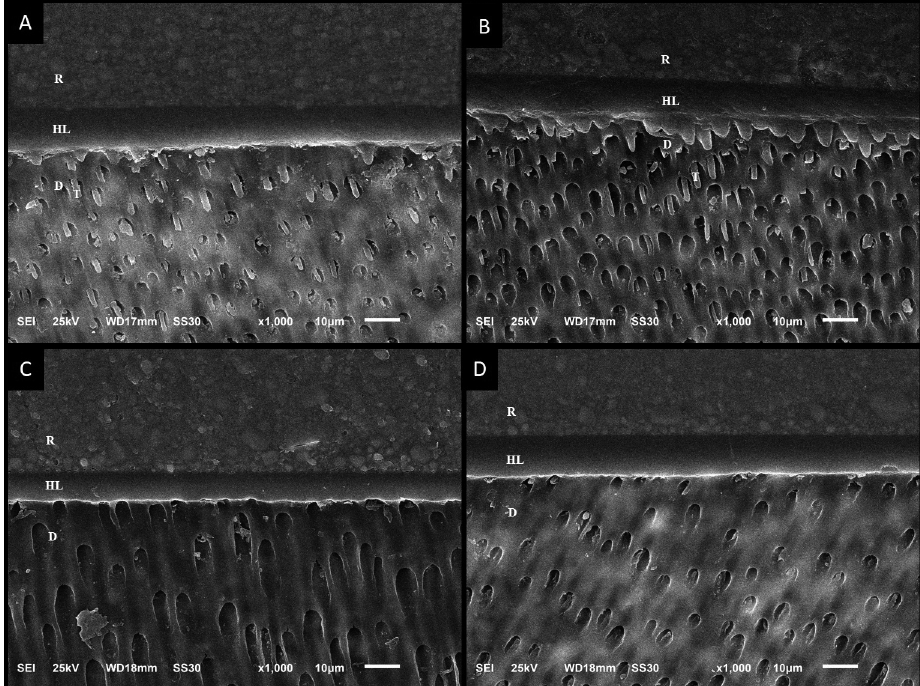
Figure 5- Photomicrographs (1000×) of the adhesive interface after 6-months aging: (A) Etch-and-rinse adhesive; (B) Chitosan + Etch- and-rinse adhesive; (C) Self-etch adhesive (D) Chitosan + Self-etch adhesive. R, resin. HL, hybrid layer. D, dentin. T, resin tags